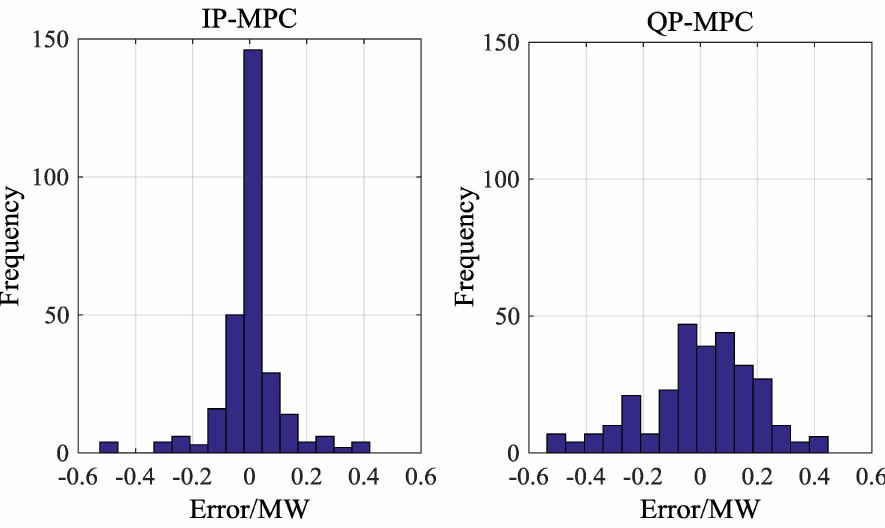
Figure 9. Wind power and dispatch power (9 MWh).